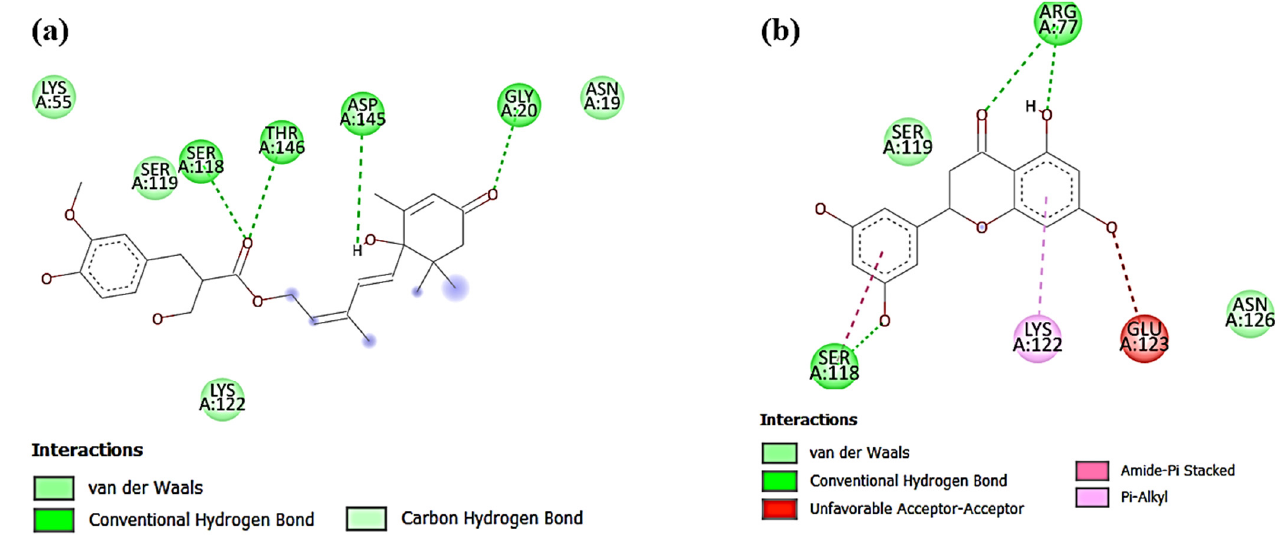
Figure 7. Two-dimensional (2D) molecular interactions of ( a ) compound C5 ; and ( b ) compound C7 with the crystal structure of human dihydrofolate reductase (DHFR) bound to NADPH (PDB ID:4M6J), (dimensions (Å); X:20.8191, Y:24.1576, Z:27.1117), (root mean square deviation) RMSD <